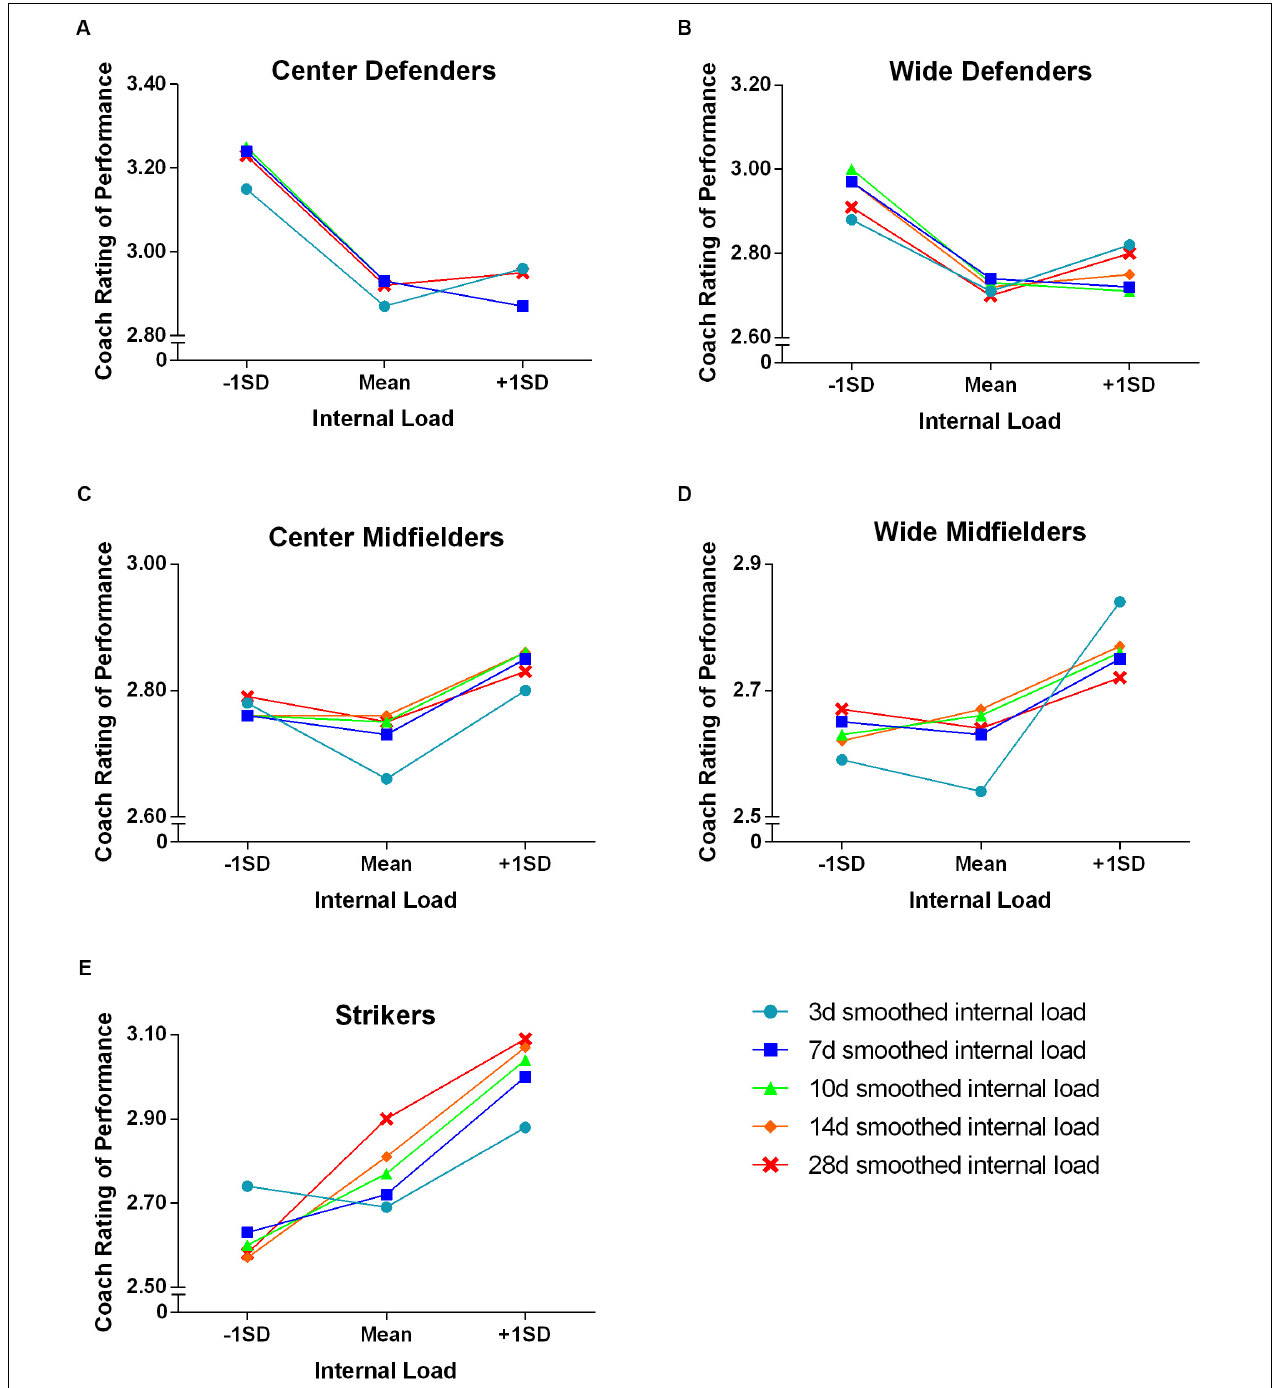
FIGURE 1 | Quadratic analysis of the change in coach rating for a given change in internal load ± 1 SD from the mean for (A) center defenders, (B) wide defenders, (C) center midfielders, (D) wide midfielders, and (E) strikers.